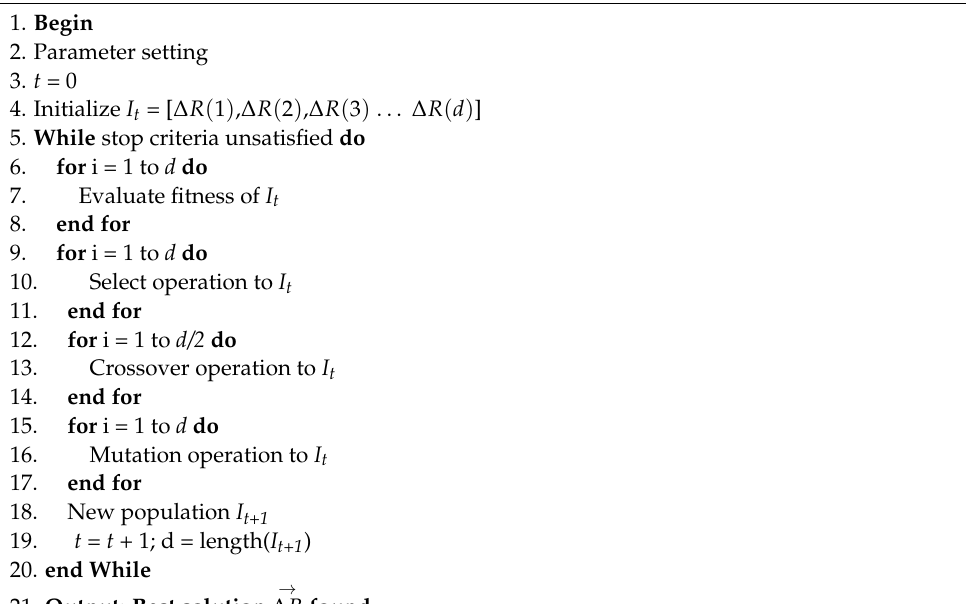
Algorithm 1: Programming steps of the genetic algorithm